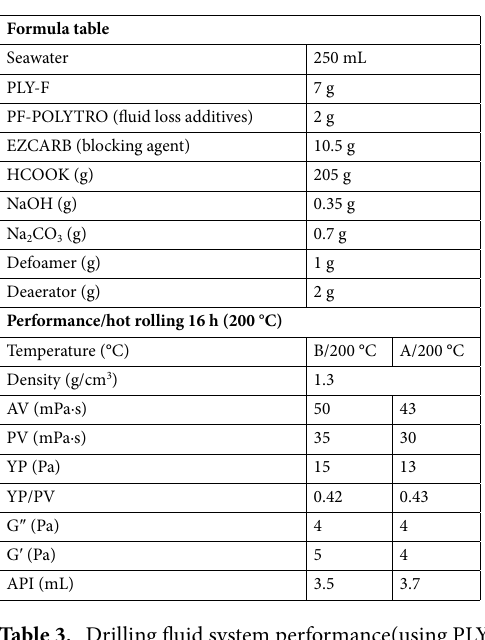
Table 3. Drilling fluid system performance(using PLY-F) .